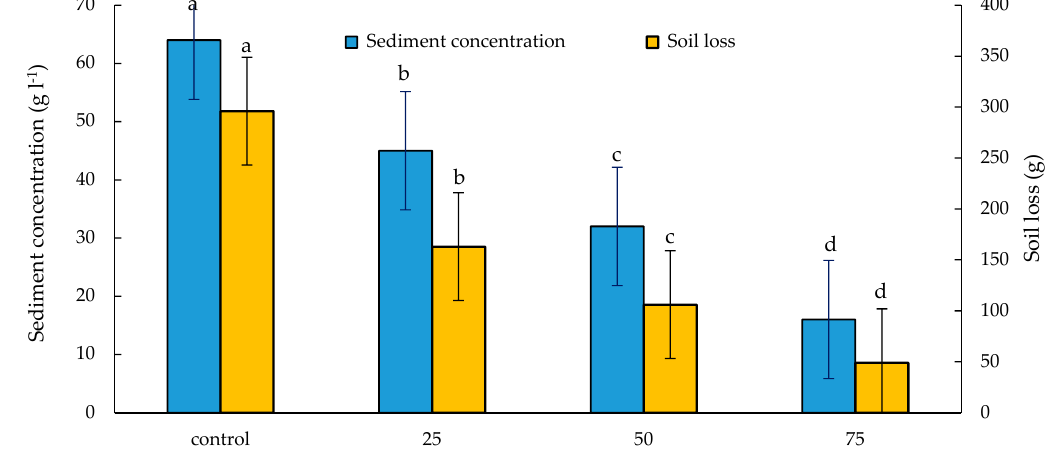
Figure 6. Comparison of soil loss and sediment concentration at different levels of corn straw mulch (above) and soil moisture conditions (below), based on the Duncan test.